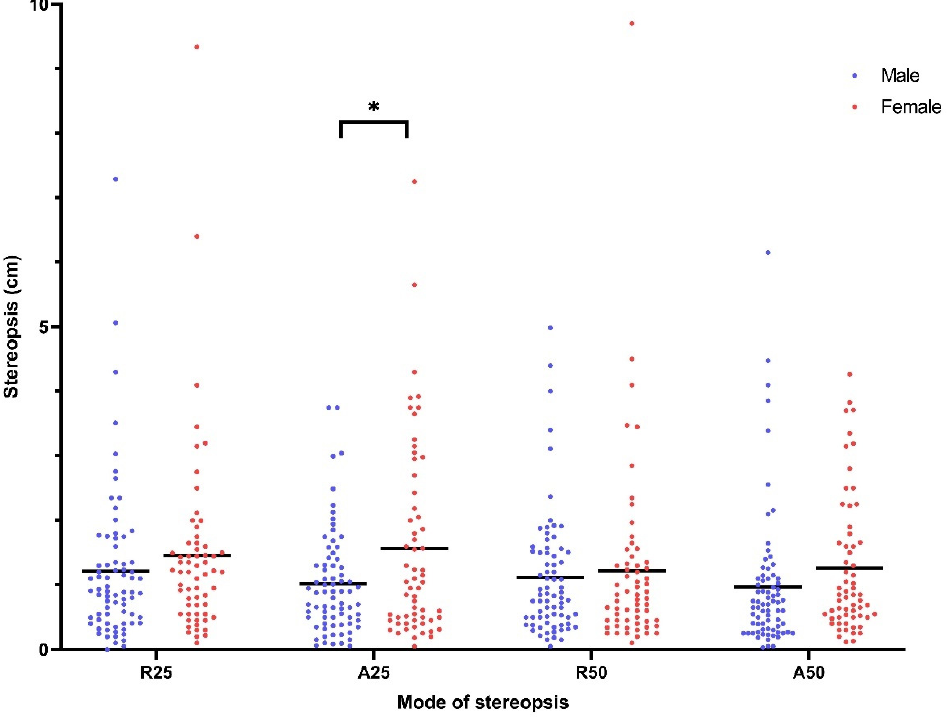
Figure 2. Stereopsis of table tennis athletes and non-athletes measured in four modes of stereopsis. (*: statistical significant between table tennis athletes and non-athletes)